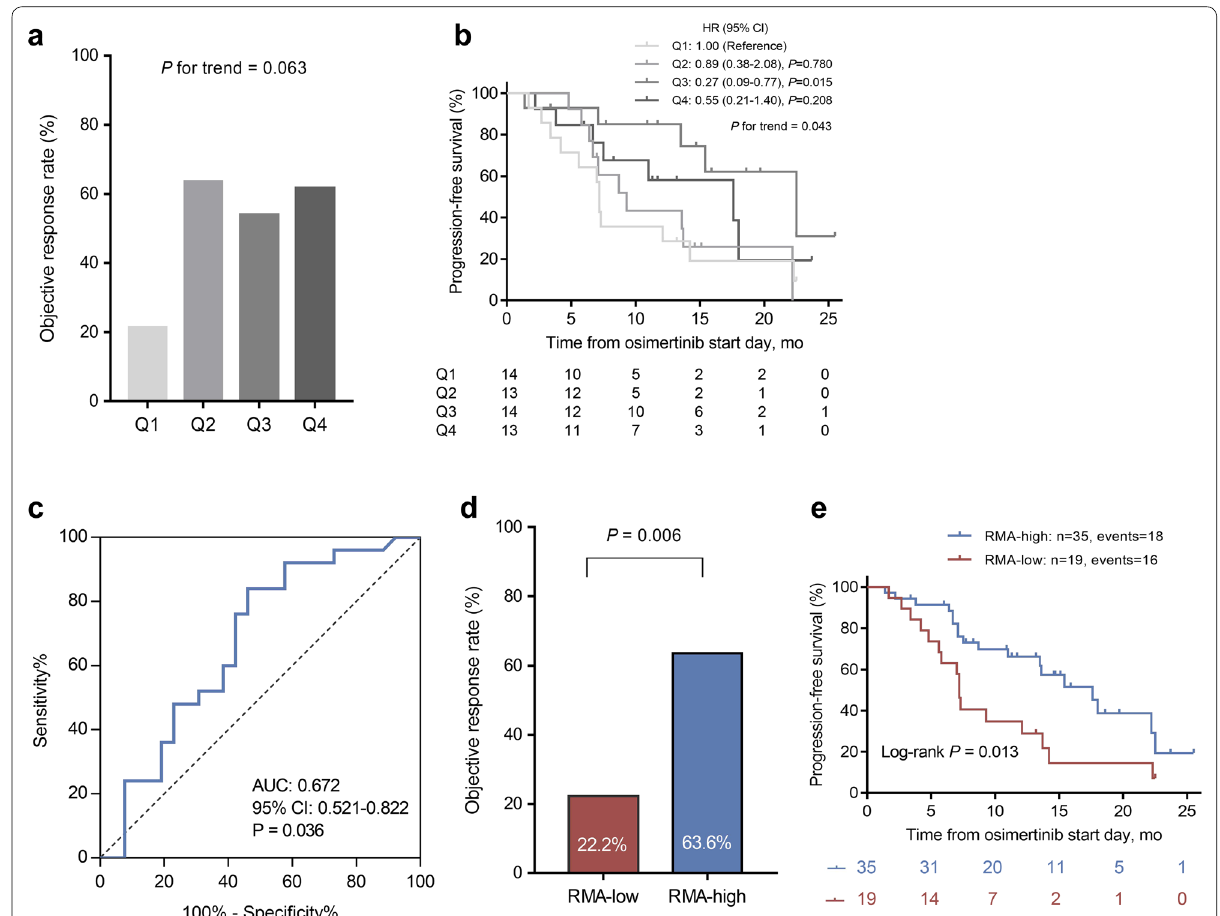
Fig. 5 Correlation between T790M relative mutation abundance (RMA) and osimertinib treatment outcomes. a Objective response rate (ORR) stratified by T790M RMA quartiles ( P for trend 0.063). b Progression-free survival (PFS) stratified by T790M RMA quartiles ( P for trend = c Receiver Operating Characteristic (ROC) Curve and area under ROC curve for T790M RMA predicting objective response. d ORR stratified by RMA-low and RMA-high patients (22.2% vs 63.6%, P 0.006). e PFS stratified by RMA-low and RMA-high patients (P =